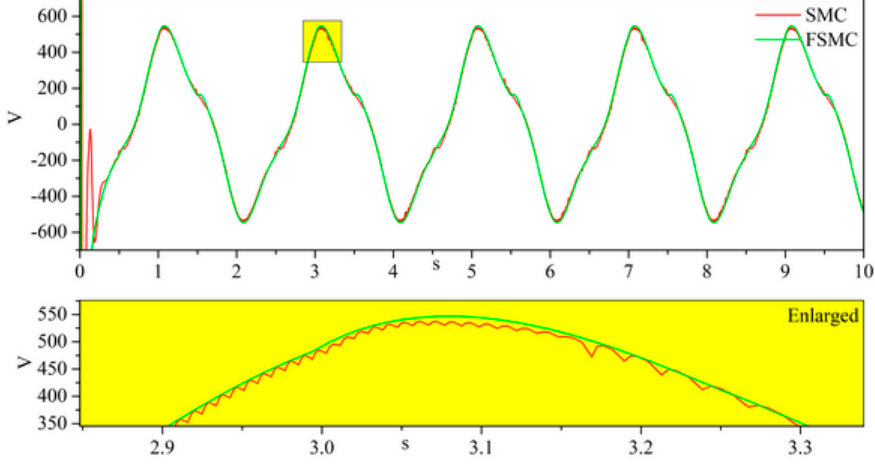
Figure 6. Output voltage of FSMC and SMC under constant gain fault (80%).